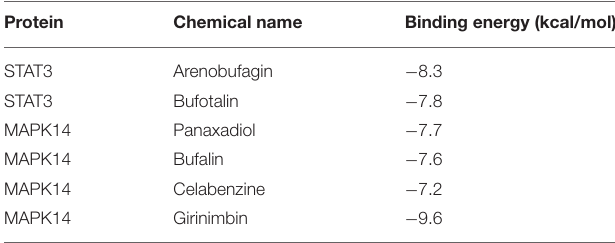
TABLE 3 | The binding energy between proteins and chemical molecules in molecular docking.